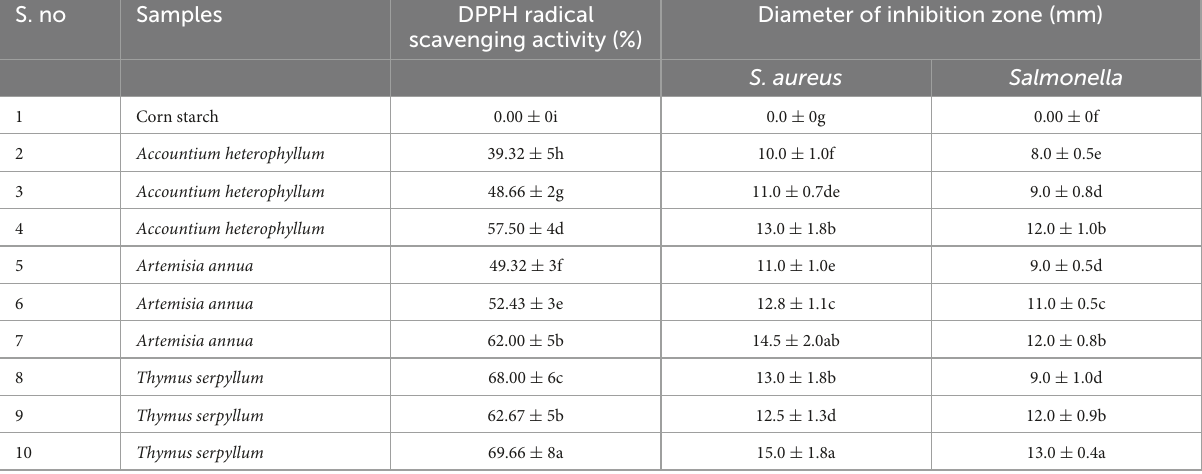
TABLE 3 Effect of starch-based films reinforced with different medicinal plants on DPPH radical scavenging activity and anti-microbial activity.